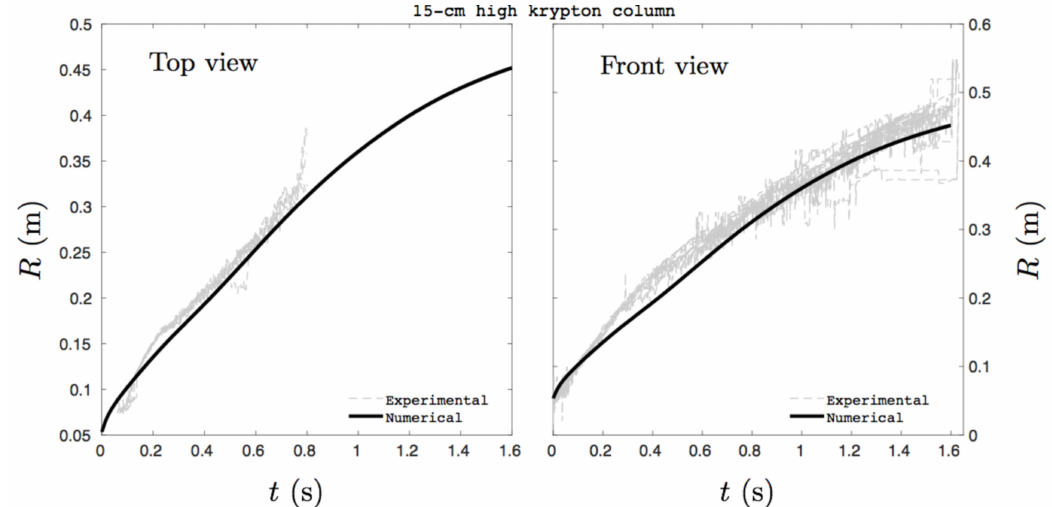
Figure 11. Temporal evolution of the krypton front position. Comparison of the one-dimensional solution of the present two-layer shallow water model versus experimental data. The initial krypton column is 15-cm high. Computed results are in good agreement with experimental